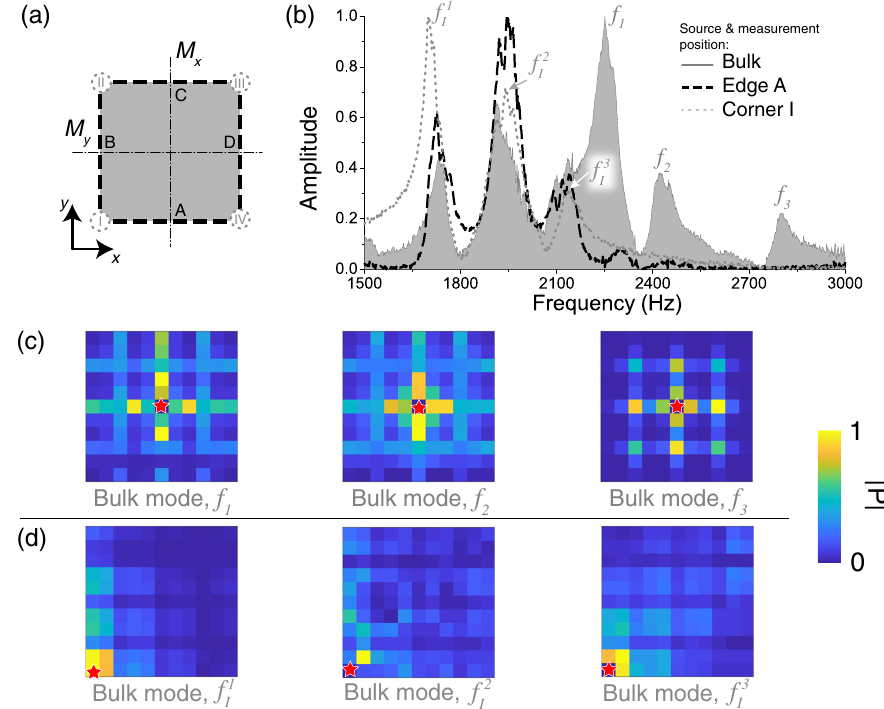
FIG. 8. Experimental results at ð ϕ x ; ϕ y Þ ¼ ð 0 ; 0 Þ . (a) A schematic drawing of the system. (b) The pressure responses with different excitation and measurement positions as indicated in the legend. (c) The field maps of the bulk modes at frequencies as indicated. (d) The field maps of the bulk modes at frequencies as indicated, with the source at corner I. The red stars in (c) and (d) indicate the source